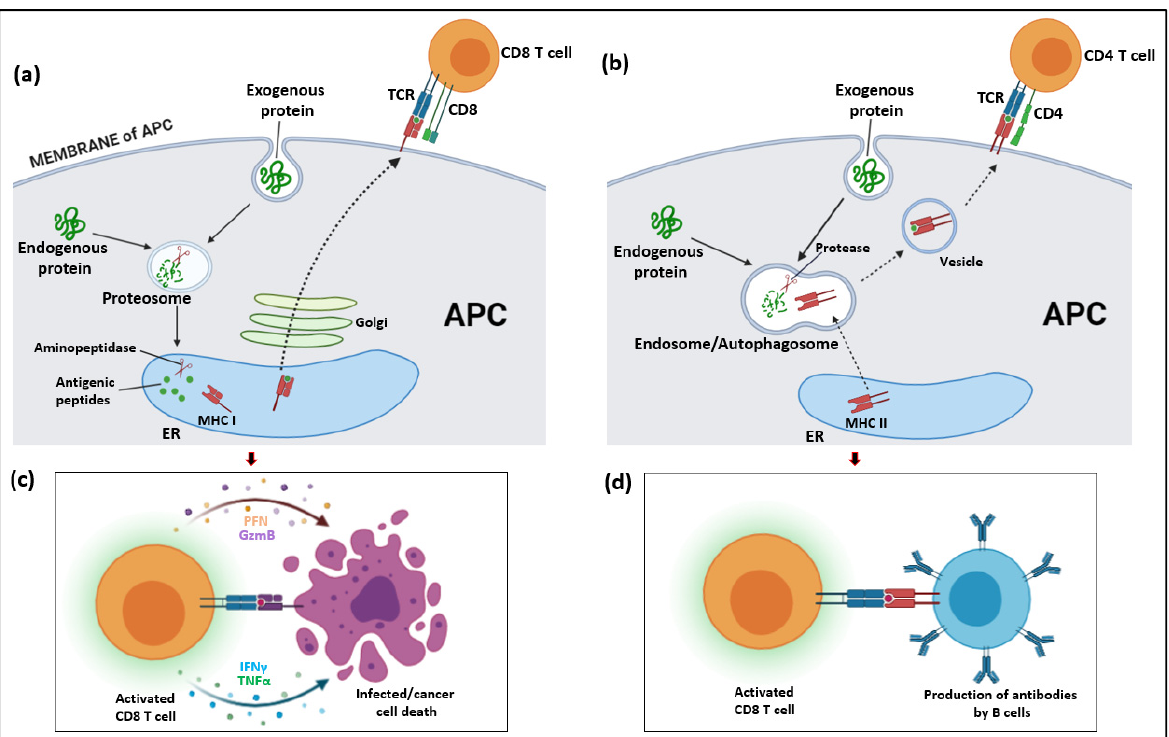
Figure 1. Mechanisms of antigen processing and T cell immune responses. ( a ) MHC class I antigen processing; ( b ) MHC class II antigen processing; ( c ) CD8 (Cytotoxic) T cell immune response; ( d ) CD4 (T helper) cell immune response.